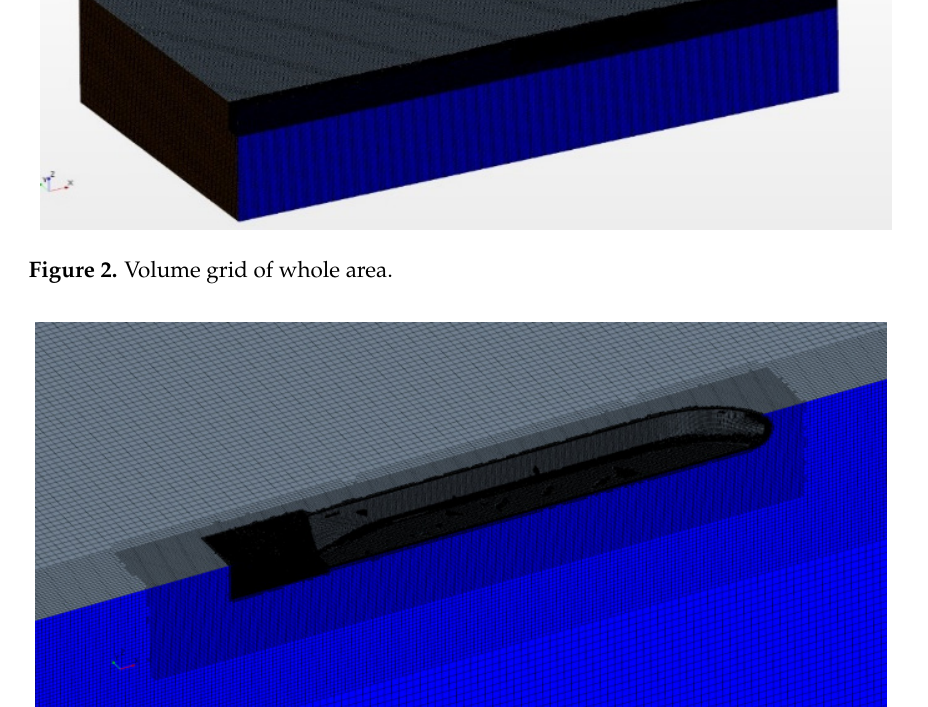
Figure 3. Volume grid of JBC around the hull.